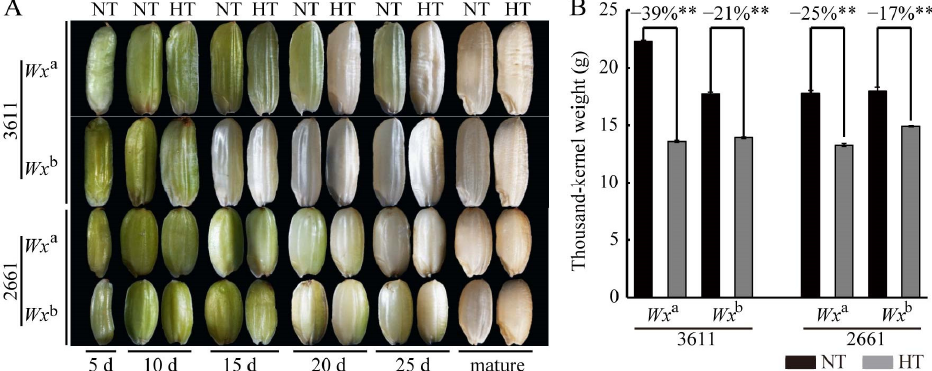
Figure 2. Dynamic analysis of grain filling in the Wx NILs with 3611 and 2661 genetic backgrounds. ( A ) Grain observation of Wx NILs treated by high temperature in different periods by photographing. “NT” stands for normal condition and “HT” stands for high-temperature condition. ( B ) Thousand- kernel weight of four materials treated by different temperatures (grains not fully ripe were also collected to measure weight). Double asterisks denote a highly significant difference using Student’s t -test ( p < 0.01). All significant-difference analyses were performed between the same samples at different